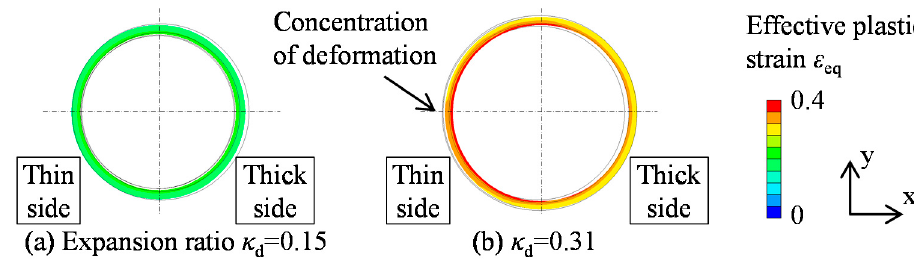
Figure 20. Effect of expansion ratio κ d on thickness deviation ratio λ .